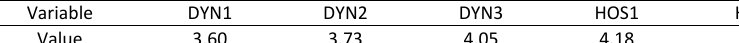
Table 1: The perception of the environment of the surveyed entrepreneurs Variable DYN1 DYN2 DYN3